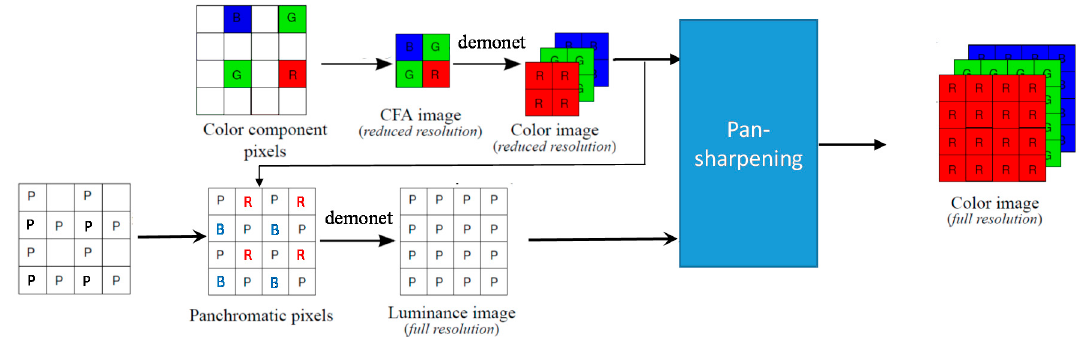
Figure 4. A hybrid deep learning and pan-sharpening approach for CFA 3.0.